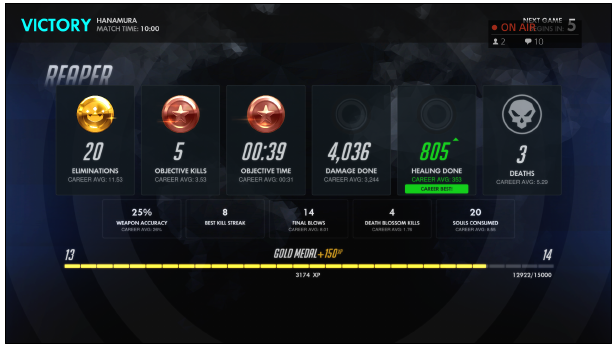
Figure 3. Session completion and rewards.